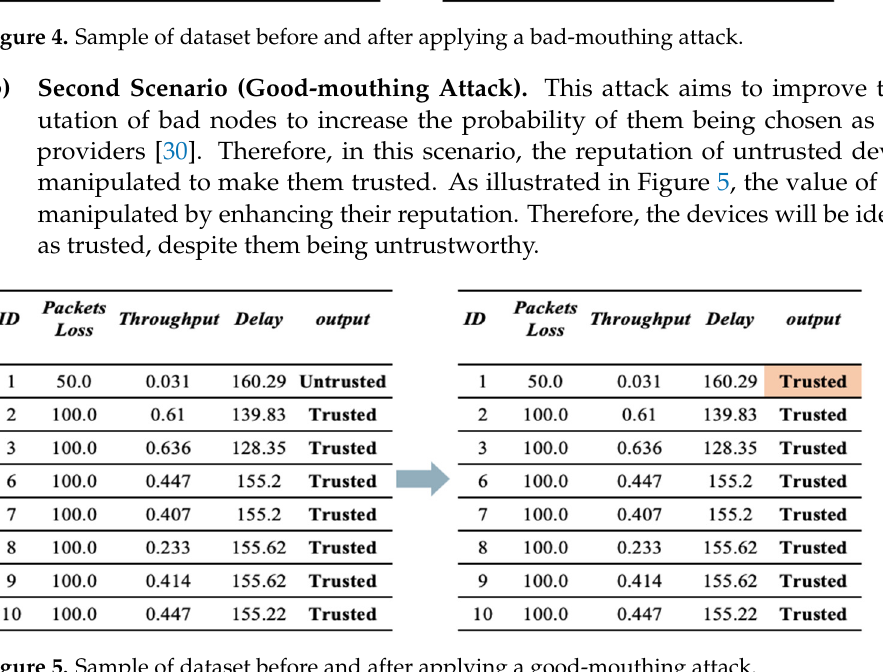
Figure 5. Sample of dataset before and after applying a good-mouthing attack.